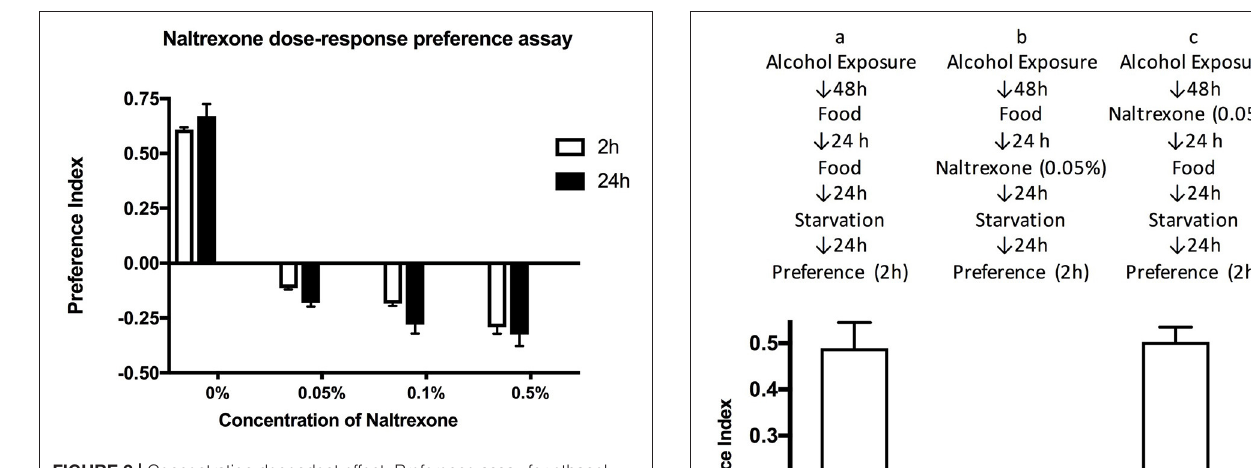
FIGURE 2 | Concentration dependent effect. Preference assay for ethanol exposed flies fed with naltrexone (0–0.5% w/v) for 24 h before being starved for 24 h and tested for ethanol preference in the CAFE assay. Preference indices measured at 2 and 24h. Columns represent three independent experiments, each consisting of three assay tubes containing 6–8 flies each. n = 9. Error bars are SEM. Statistical significance was measured by two-way ANOVA with Bonferroni multiple comparisons test. The effect of naltrexone treatment was overall highly significant p < 0.0001 but there was no statistical difference between consecutive naltrexone concentrations tested. The effect of time was not significant p = 0.175.